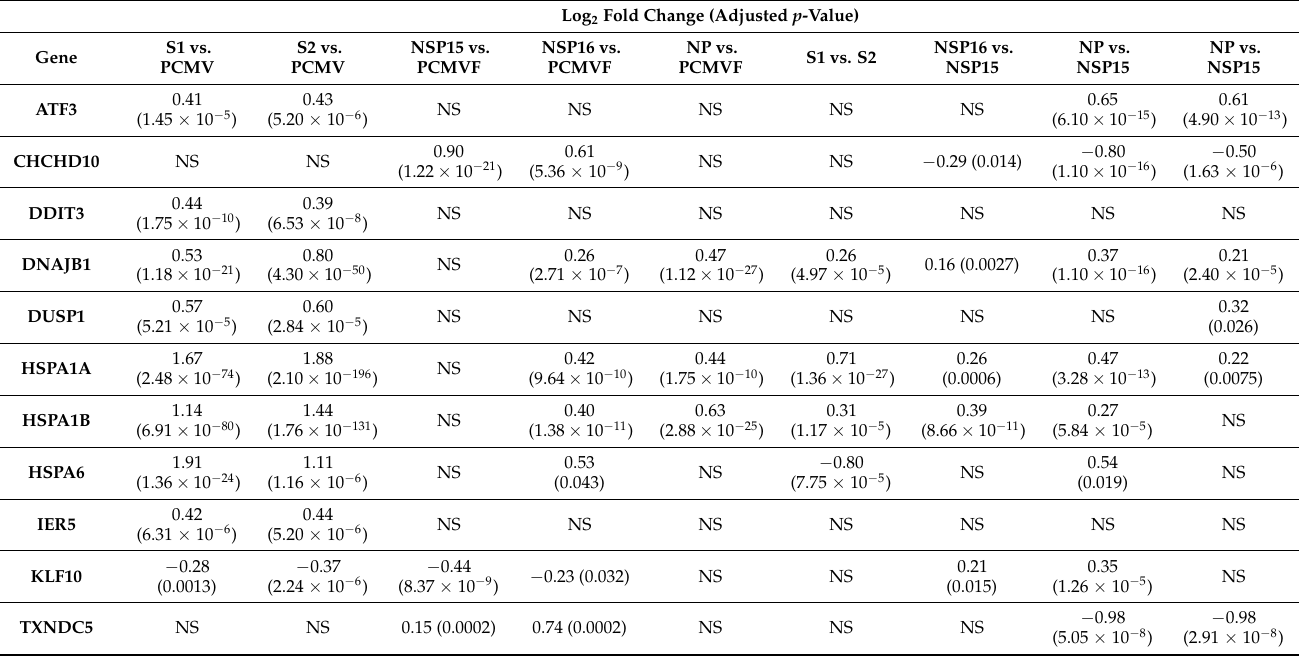
Table 3. Average log 2 fold change of selected human genes of interest across RNA samples of HL-CZ cells expressing different SARS-CoV-2 genes (versus plasmid vector controls).